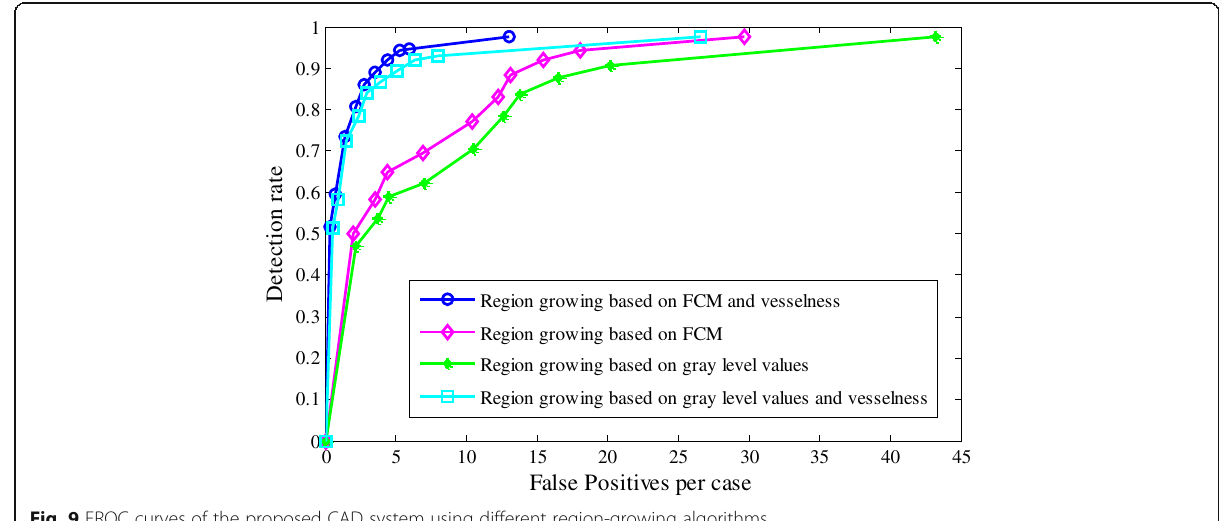
Fig. 9 FROC curves of the proposed CAD system using different region-growing